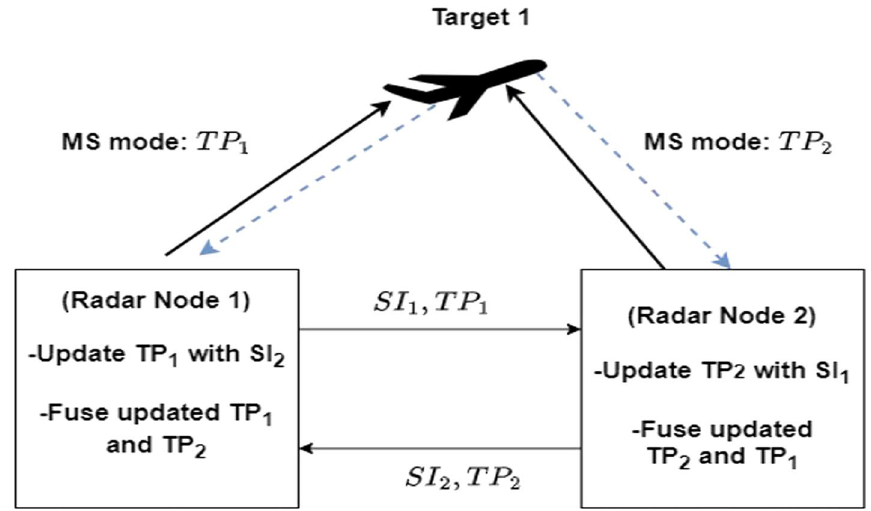
Fig. 1 Schematic of information embedding through waveform diversity in radar